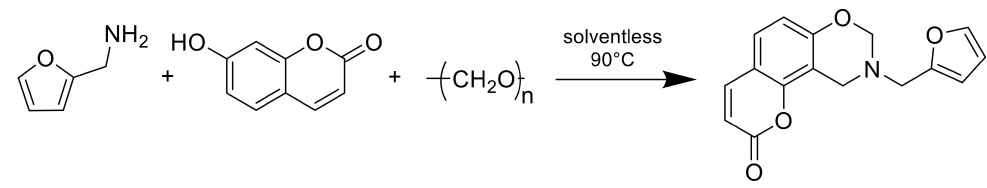
Figure 19. Synthesis of the first fully bio-based benzoxazines. Table 1. Thermal properties of the three different benzoxazine resins [141].